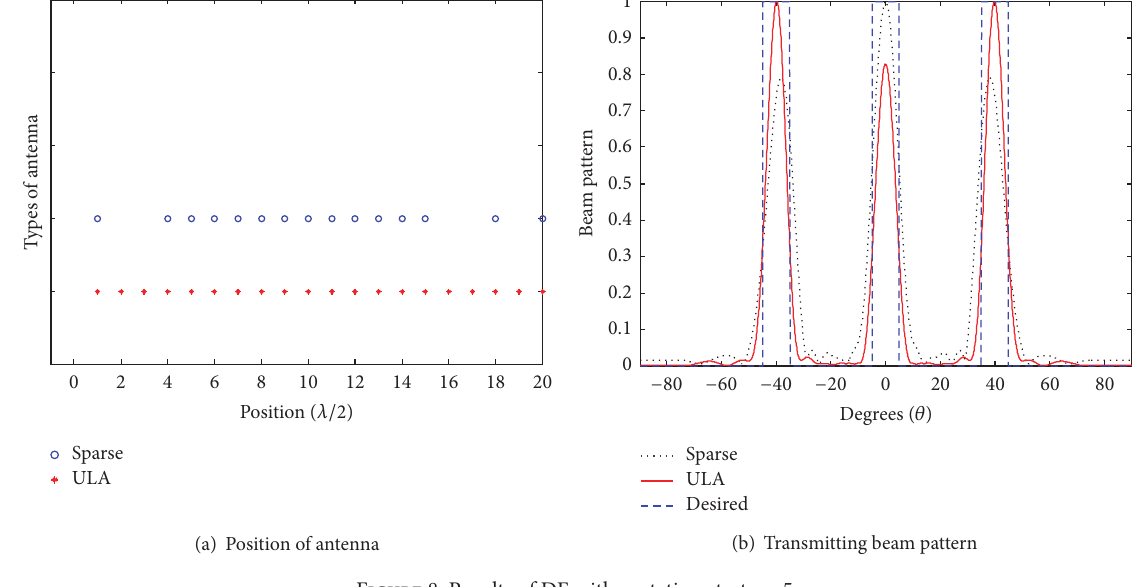
Figure 8: Results of DE with mutation strategy 5.